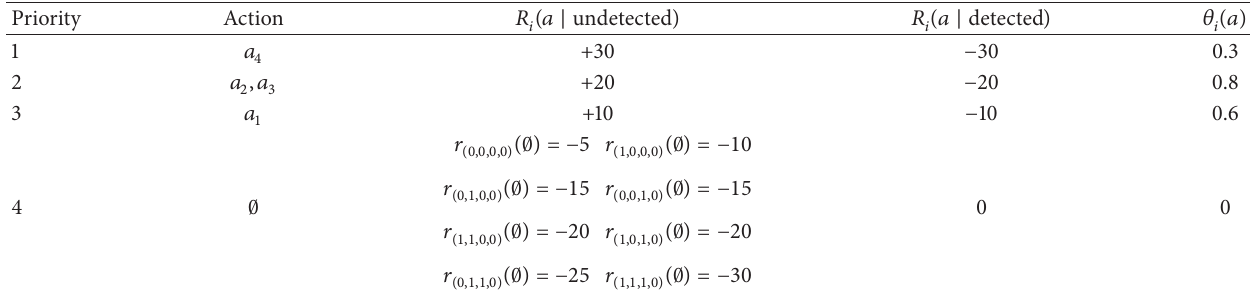
Table 1: Priorities, rewards, costs, and detection probabilities of attack actions.